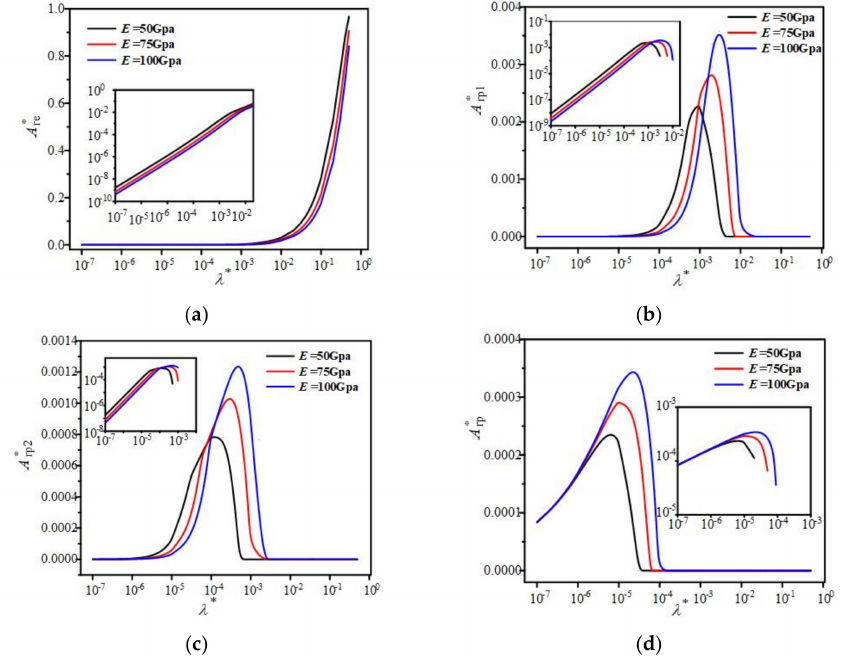
Figure 10. The real contact area A r * in different contact stages versus the λ * with various E. ( a ) Dimensionless elastic contact area A re * versus λ *. ( b ) Dimensionless elastoplastic contact area A rep1 * in the first stage versus λ *. ( c ) Dimensionless elastoplastic contact area A rep2 * in the second stage versus λ *. ( d ) Dimensionless plastic contact area A rp * versus λ